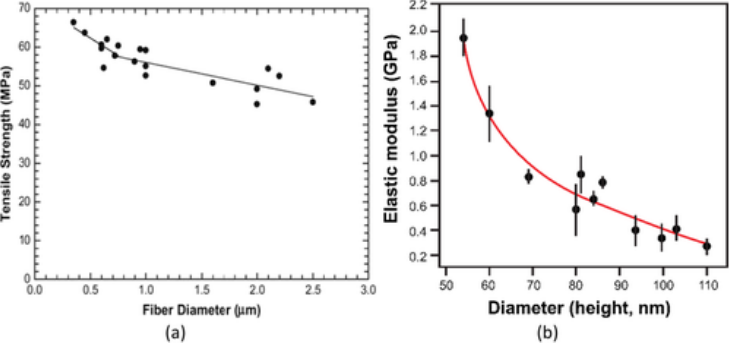
Figure 25. ( a ) Tensile strength and tensile modulus versus diameter. ( b ) Variation in measured elastic modulus as a function of diameter for poly(2-acrylamido-2-methyl-1-propanesulfonic acid) nanofiber. Reproduced from: ( a ) [164] with permission of Elsevier and ( b ) [165] with permission of AIP Publishing.